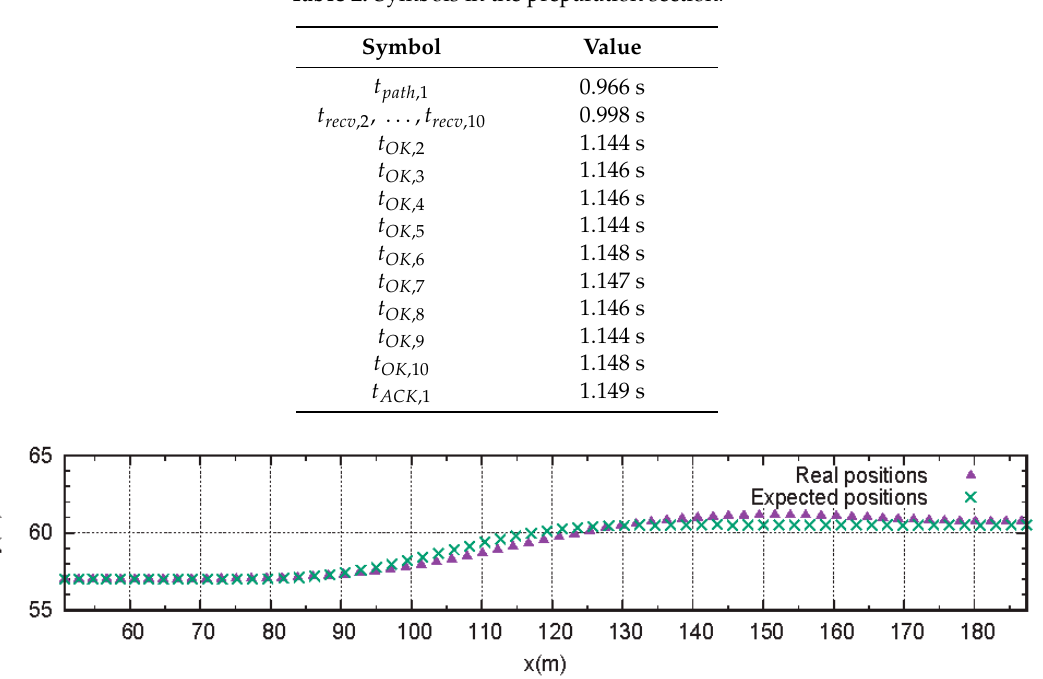
Figure 7. Real positions and expected positions of the host CAV in the lane change.